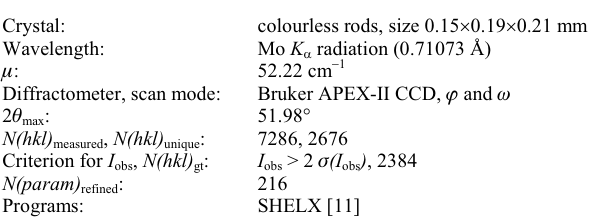
Table 1. Data collection and